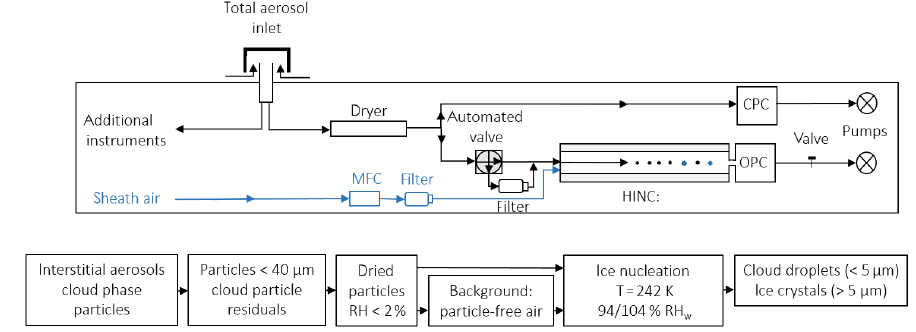
Figure 7. Schematic of aerosol flow and instrument setup during field measurements at the JFJ research station.